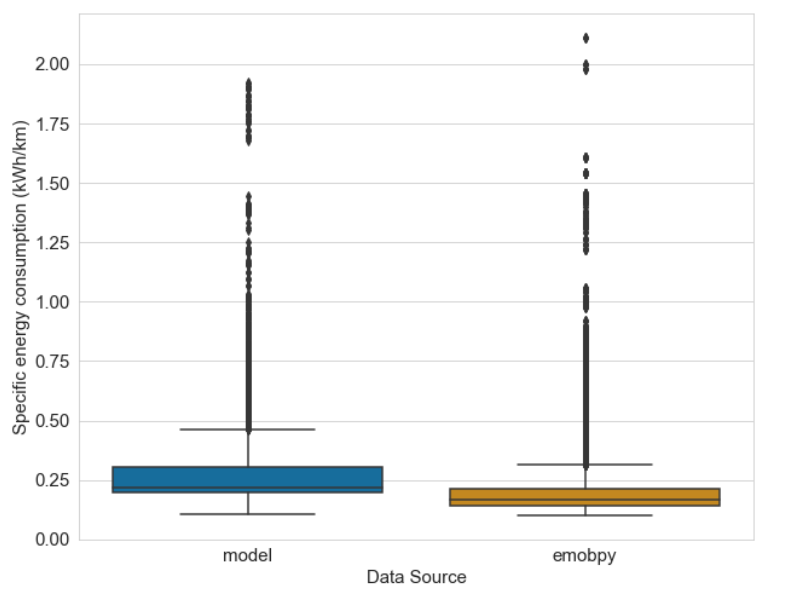
Figure 4. Model Output comparison: electric energy consumption (kWh) for both UTS (model) [13] and emobpy [54].